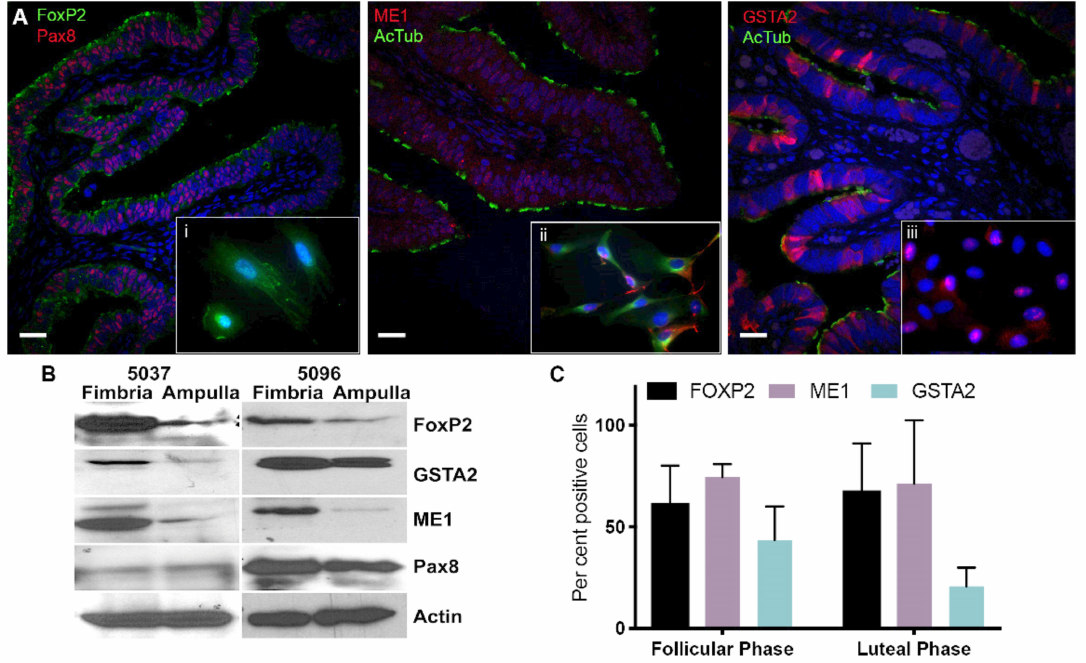
Figure 4. GSTA2, ME1 and FOXP2 show higher expression levels in the fimbria compared to the ampulla. ( A ) Immunofluorescence (IF) of the fimbria. The top panel shows a view of fimbria tissue at 10 × magnification stained for GSTA2, ME1, FOXP2, PAX8 and ac-TUBULIN. In each panel an inset shows cells derived from fresh fimbria tissue, which were cultured on chamber slides, stained with the above markers and visualized at 63 × magnification. Pax8 was used to identify secretory cells and acetylated-tubulin was used to show ciliated cells. Insets, i: FoxP2 and Pax8 localization in an FTE cell, ii : ME1 and acetylated-tubulin are found in the cytoplasm of cells and iii : GSTA2 and acetylated-tubulin expression in cells from normal FTE. GSTA2 is localized to the nucleus of FTE cells. ( B ) Immunoblot of two independent fresh fimbria and ampulla tissues from normal cases shows that GSTA2, FoxP2 and ME1 are highly expressed in fimbria compared to the ampulla. ( C ) IF was used to quantify the number of cells expressing GSTA2, FoxP2 and ME1 in the follicular and luteal phases. Scale bar: 100 µ m. The uncropped blots and molecular weight markers of Figure 4B are shown in Figure